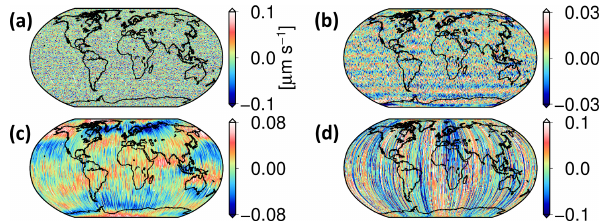
Figure 7. Spatial distribution of (a) short timescale, (b) medium timescale, (c) long timescale, and (d) approximation components of the residual signal. The values are plotted with respect to the GRACE-A ground track for December 2008.